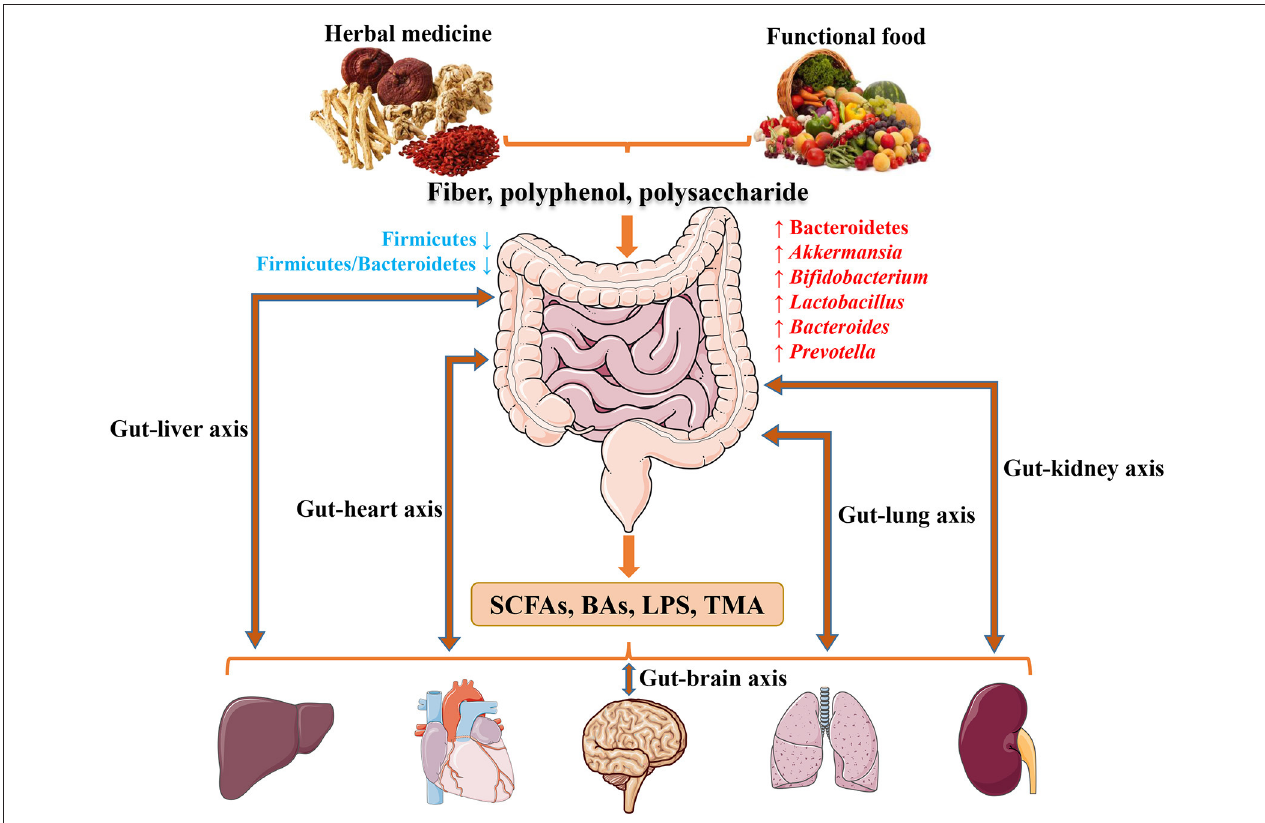
FIGURE 1 | The potentially shared biological processes and underlying mechanisms of herbal medicine and functional food for CMDs through modulating